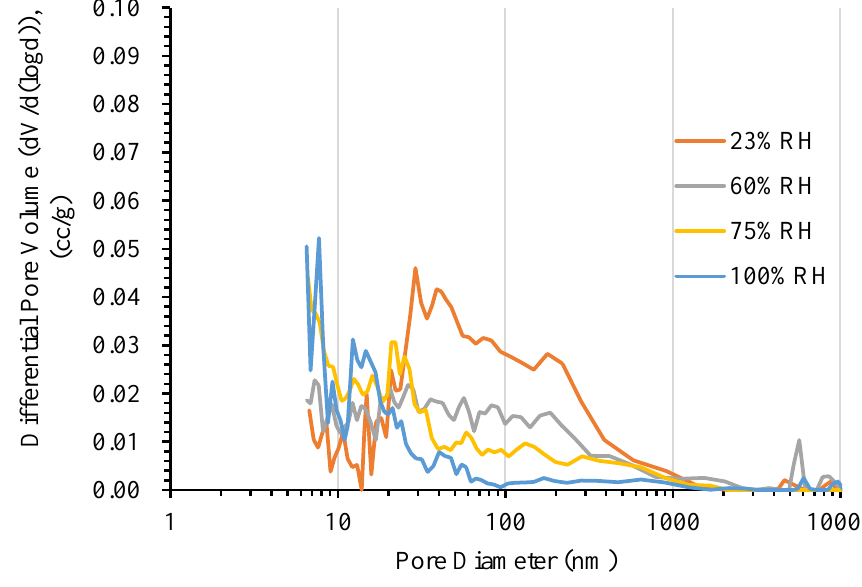
ff erential pore size distribution of mortar at 20 ◦ Figure 2. The differential pore size distribution of mortar at 20 °C. Figure 2. The di